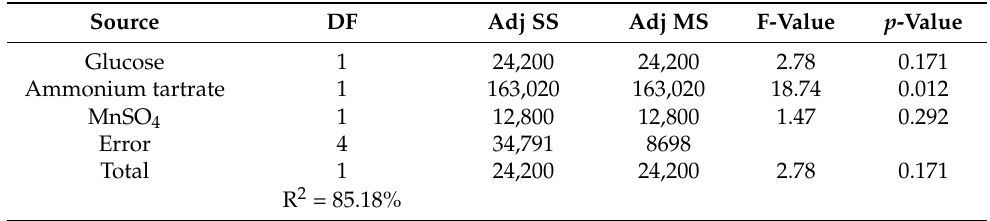
Table 1. Order of significance for each factor by